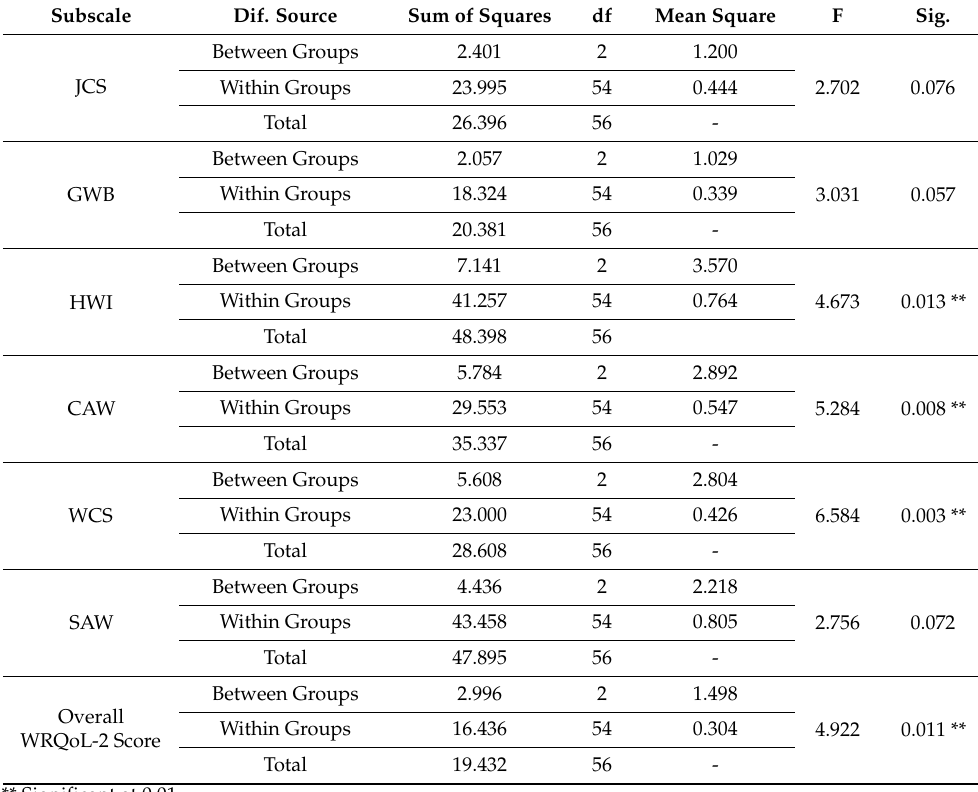
Table 6. WRQoL-2 Subscales According to Age Variable. Subscale Dif. Source Sum of Squares Mean Square Between Groups JCS Between Groups